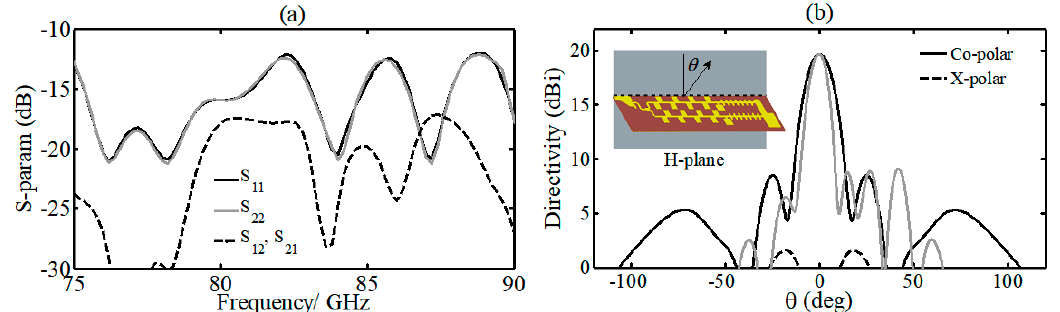
Figure 5 . ( a ) Simulated magnitude of the reflection coefficient and cross-talk for the complete array. ( b ) Simulated E-plane (black) and H-plane (grey) cuts of the radiation pattern for broadside emission at 81 GHz.